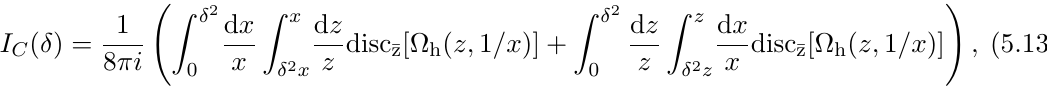
minus two small